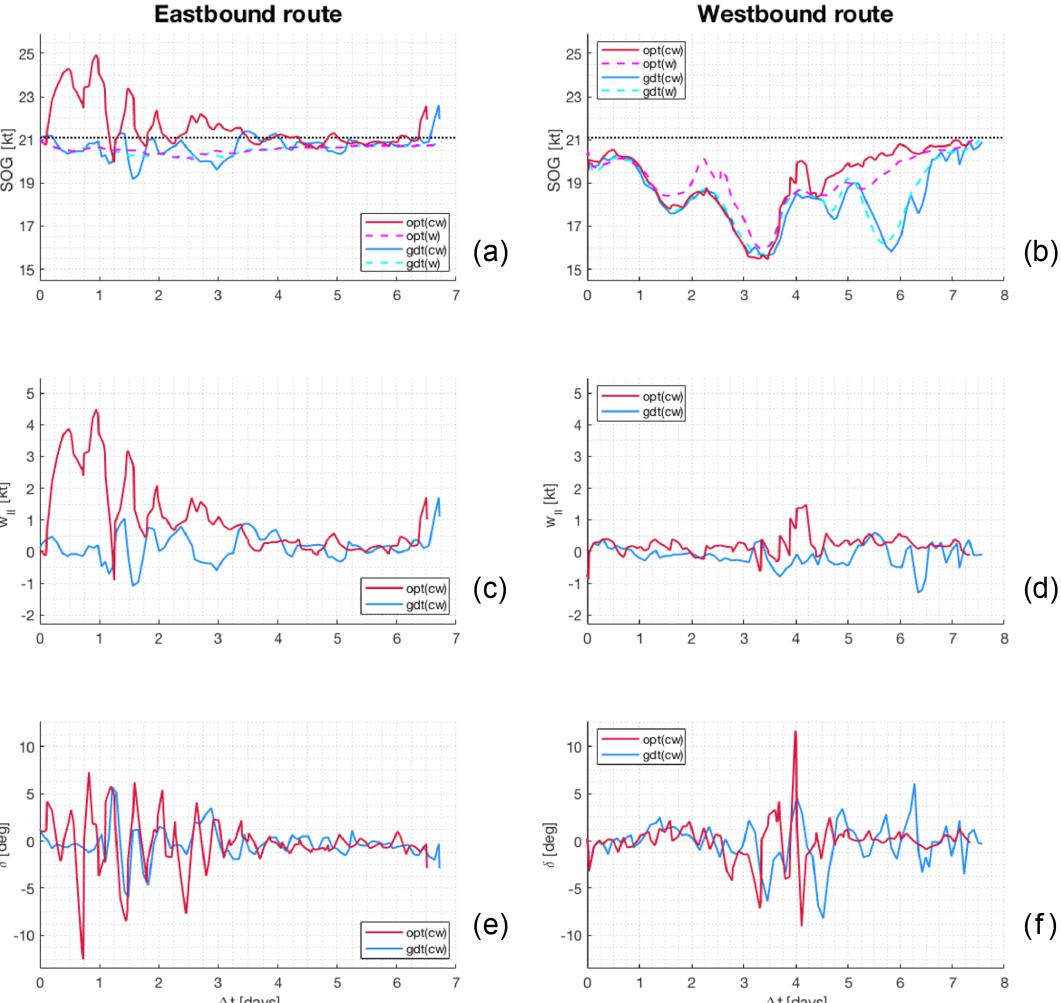
Figure 6. Along-route information for both the eastbound (a, c, e) and westbound (b, d, f) crossings of Fig. 5. The first row (a, b) displays the SOG for both optimal and geodetic tracks for both w and cw cases; the black dotted line is V max from Table 4. The second row (c, d) displays the w (cid:107) component of the ocean flow, as computed from Eq. (4a). The third row (e, f) displays the angle of attack δ from Eq. (5). The maximum ROT of δ is 0.8 and 0.5 ◦ min − 1 for the east- and westbound track,